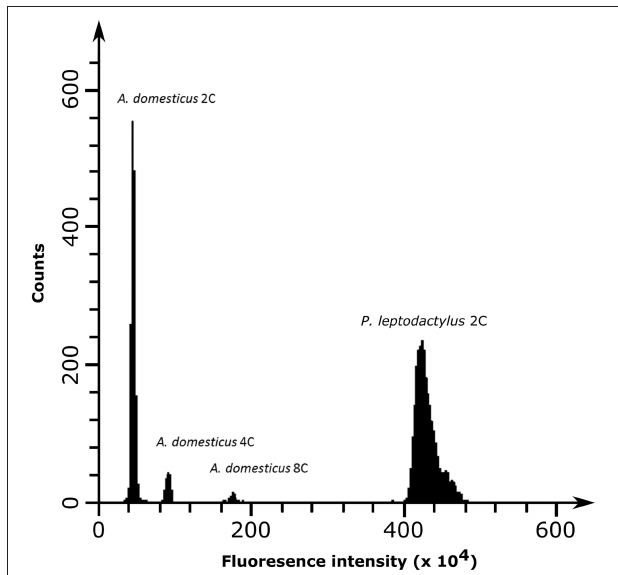
FIGURE 2 | Flow cytometry histograms of neural tissue from house cricket Acheta domesticus 2C (first peak), A. domesticus 4C (second peak), A. domesticus 8C (third peak), and vascular tissue from P. leptodactylus (fourth peak) obtained by PI fluorescence dye excitation and counts representing the cell population.